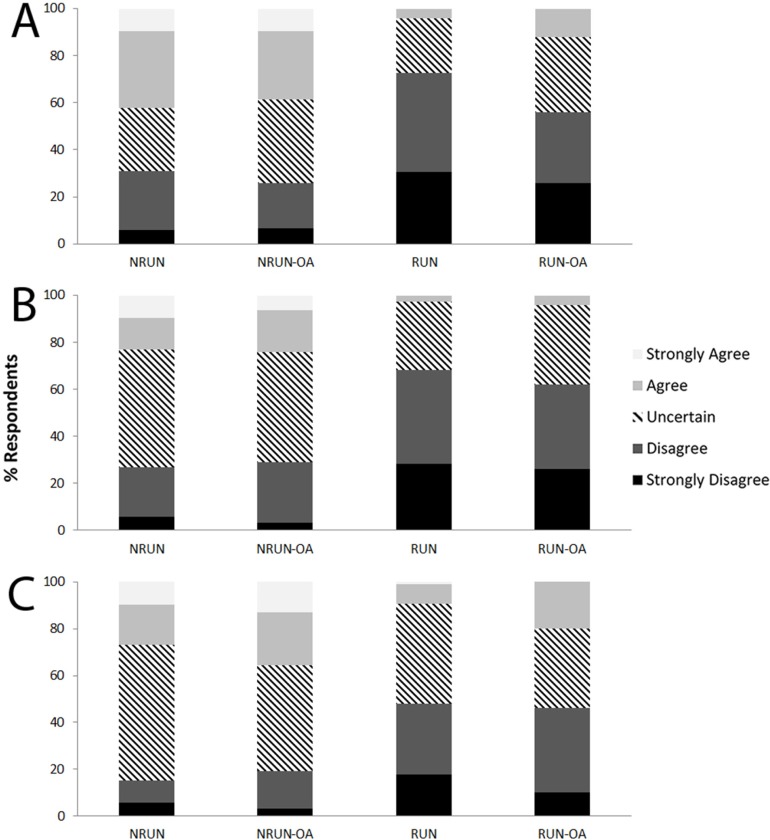
Perception of non-runners and runners about running and the development of knee osteoarthritis.(A) “In general, I see regular running as an activity that hurts the knee joint”; (B) “Frequent running can lead to getting knee osteoarthritis”; (C) “Running long distances (such as marathons and ultra-marathons) can lead to getting knee osteoarthritis”.